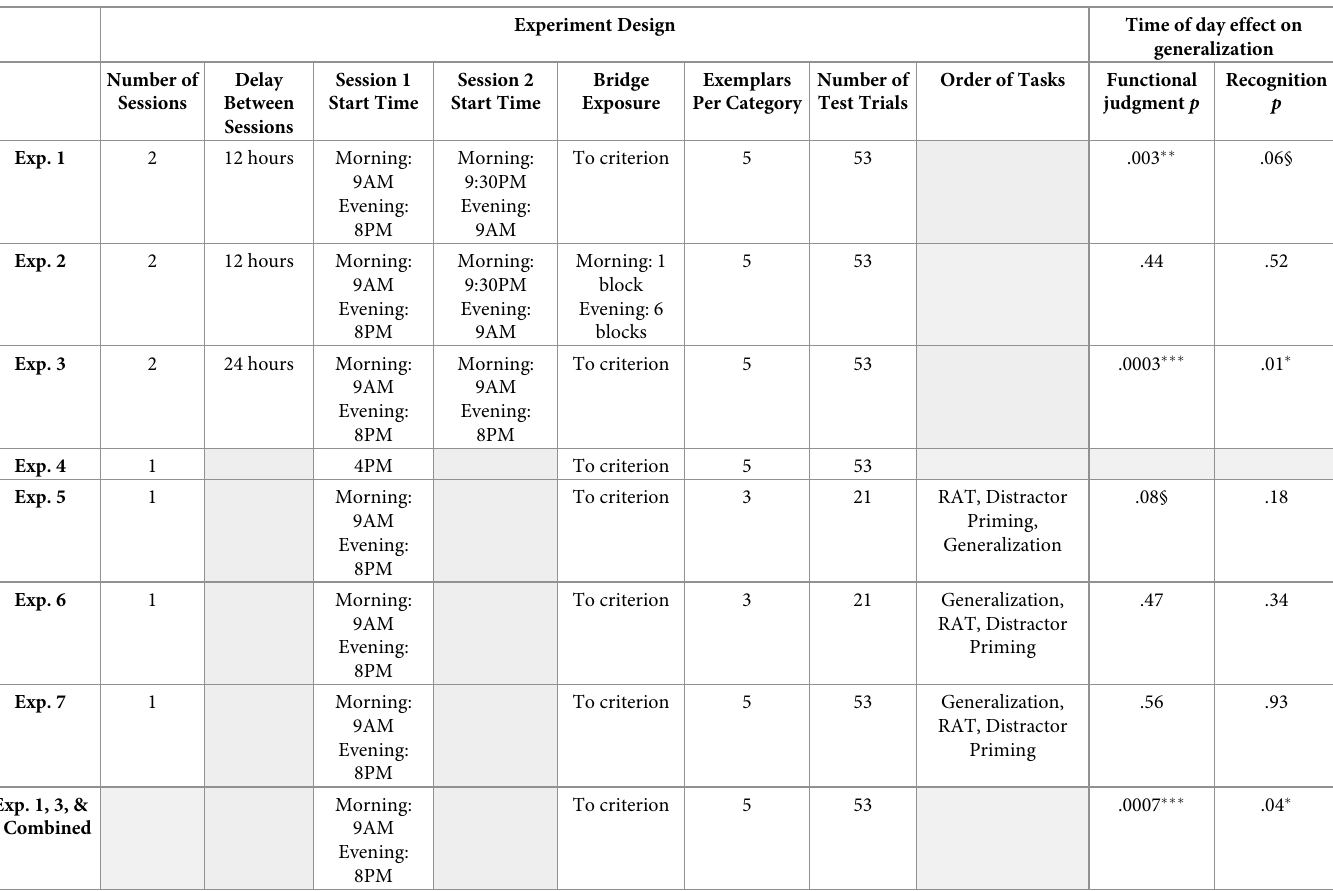
Table 1. Experiment design and time of day effects on